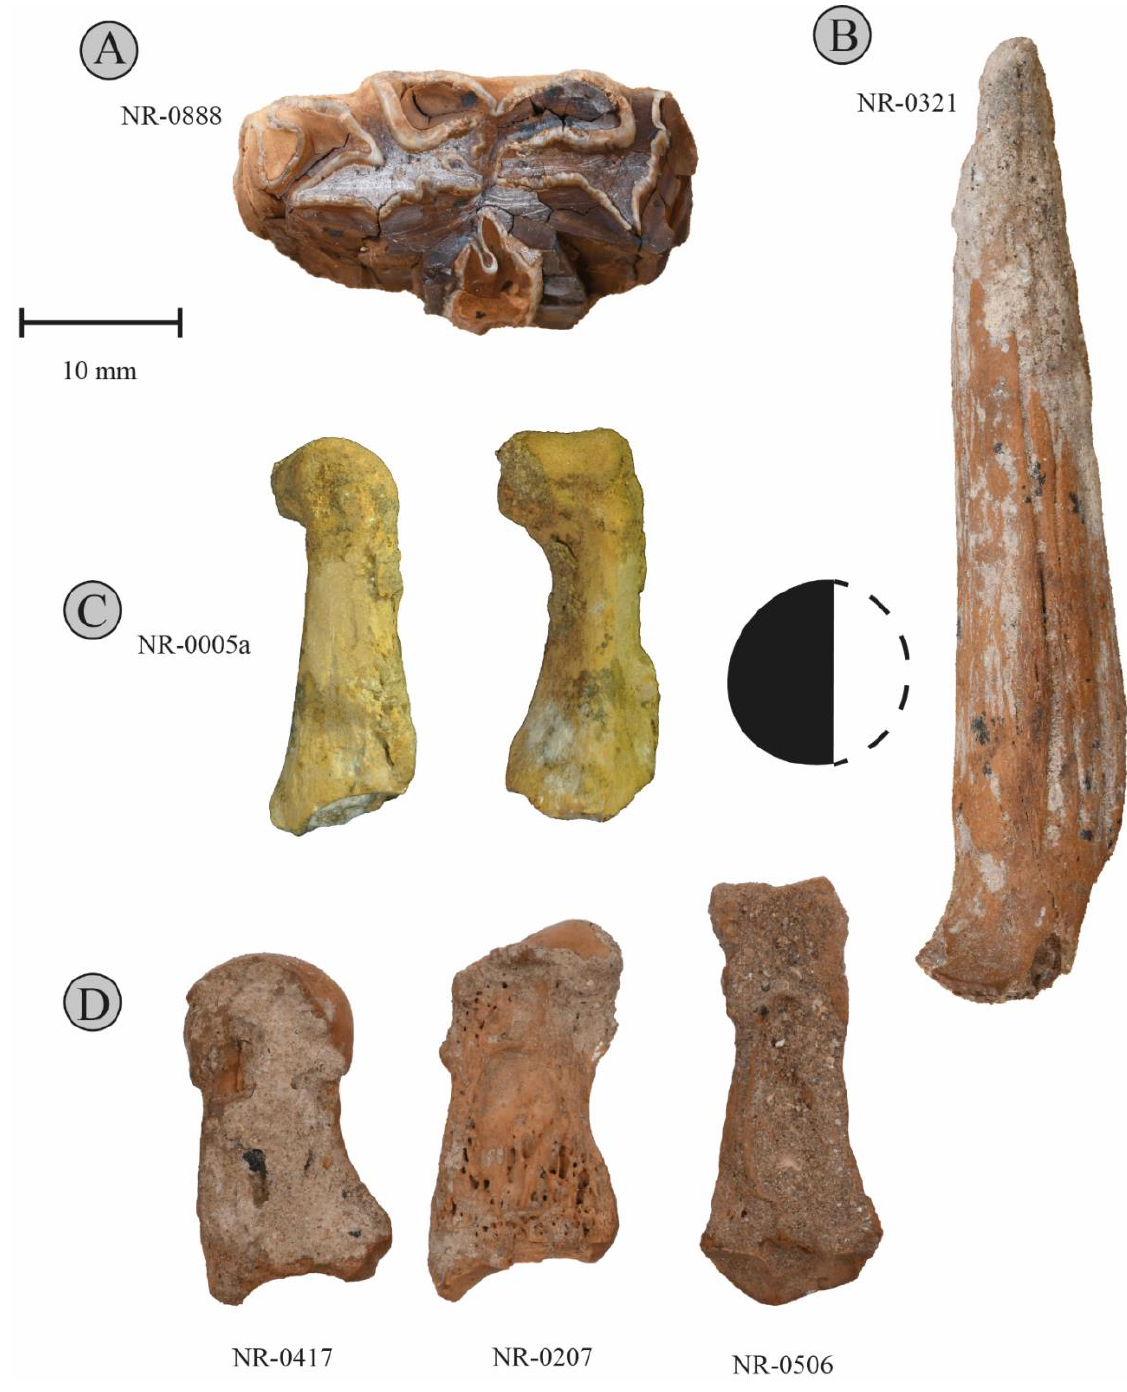
Figure 2: (A) right-sided mandibular premolar of an assinine equid (Layer 7a); (B) female Gazella gazella horncore (Layer 7), with cross section of the posterior part of the base; (C) leopard ( Panthera pardus ) phalanges (Layer 5). (D) longitudinally-split phalanges. Photographs by Roee